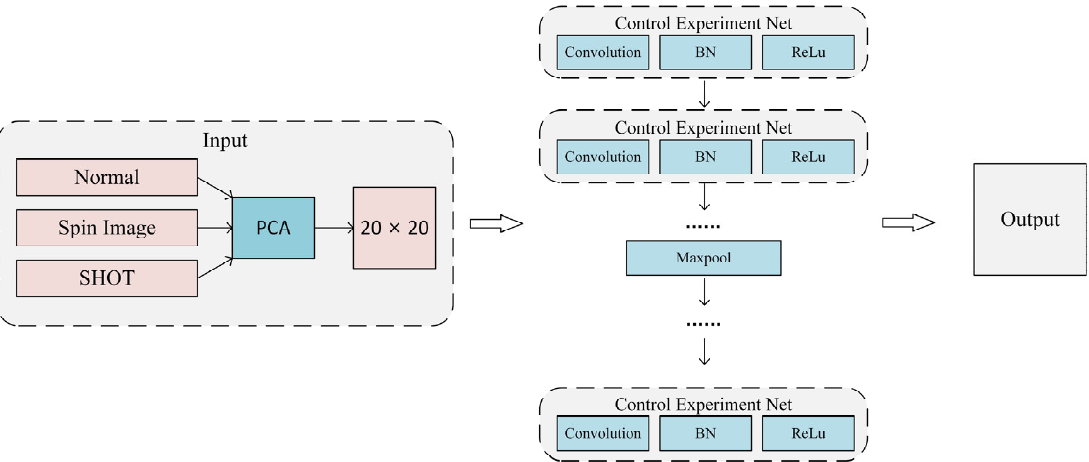
Figure 8. Network structure of the control experiment.